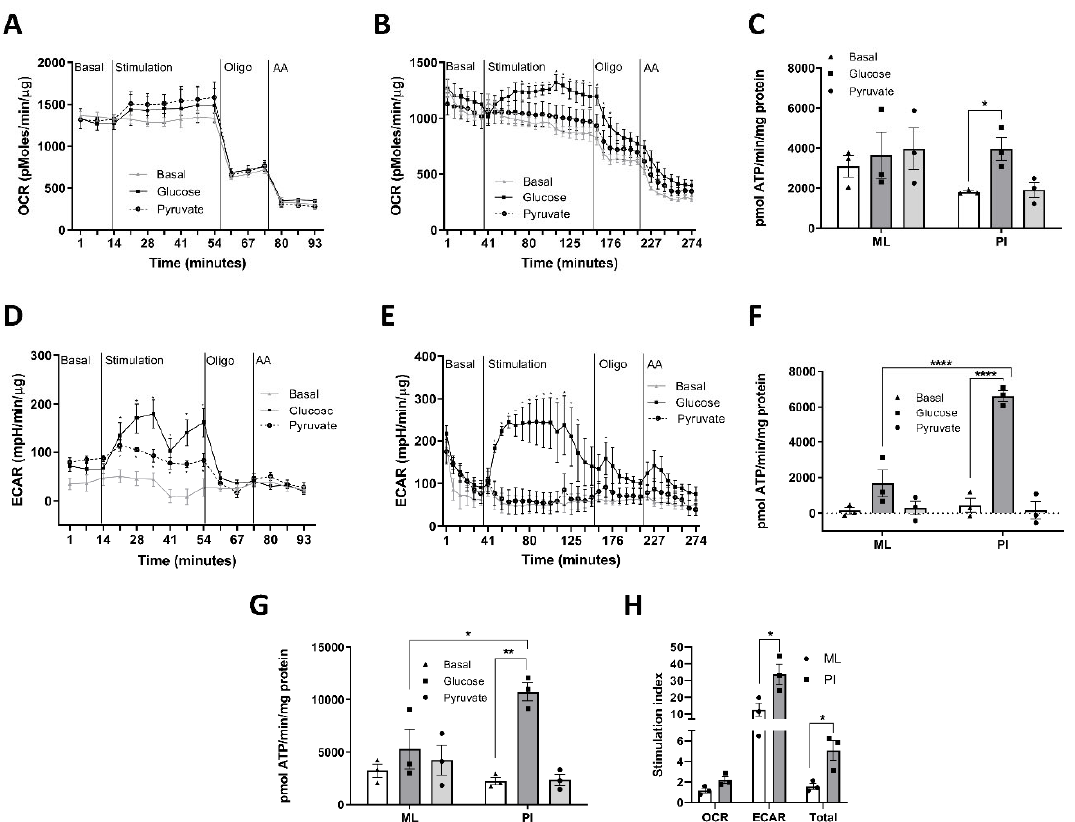
Figure 2. Pseudoislet formation increases ATP production in response to glucose. MIN6 cells (passage 26–29) were cultured in Seahorse 24-well plates for 5 days (ML) or un-coated Petri-dishes for 4 days before transfer to a 24-well islet capture plate for 24 h (PI). The Oxygen Consumption Rate (OCR) and Extracellular Acidification Rate (ECAR) were measured using the Seahorse XFe24 well analyser with additions of either media only (Basal), Glucose (25 mM), Pyruvate (10 mM) at time point 1 followed by Oligomycin (2 µ M for ML, 20 µ M for PI) at time point 2 or antimycin A (0.5 µ M) at time point 3, as indicated. ( A ) OCR for ML expressed as pmol/min/ µ g protein. ( B ) OCR for PI expressed as pmol/min/ µ g protein. ( C ) ATP production from OCR as calculated outlined in the methods and expressed as pmol ATP/min/mg protein. ( D ) ECAR for ML expressed as mpH/min/ µ g protein. ( E ) ECAR for PI expressed as mpH/min/ µ g protein. ( F ) ATP production from ECAR expressed as pmol ATP/min/mg protein. ( G ) Total ATP production from OCR and ECAR expressed as pmol ATP/min/mg protein. ( H ) Stimulation index was calculated as the ratio of stimulated (glucose) to basal ATP production (basal). n = 3. * p < 0.05, ** p < 0.01, **** p < 0.001 using a 2-way ANOVA followed by Bonferroni post hoc